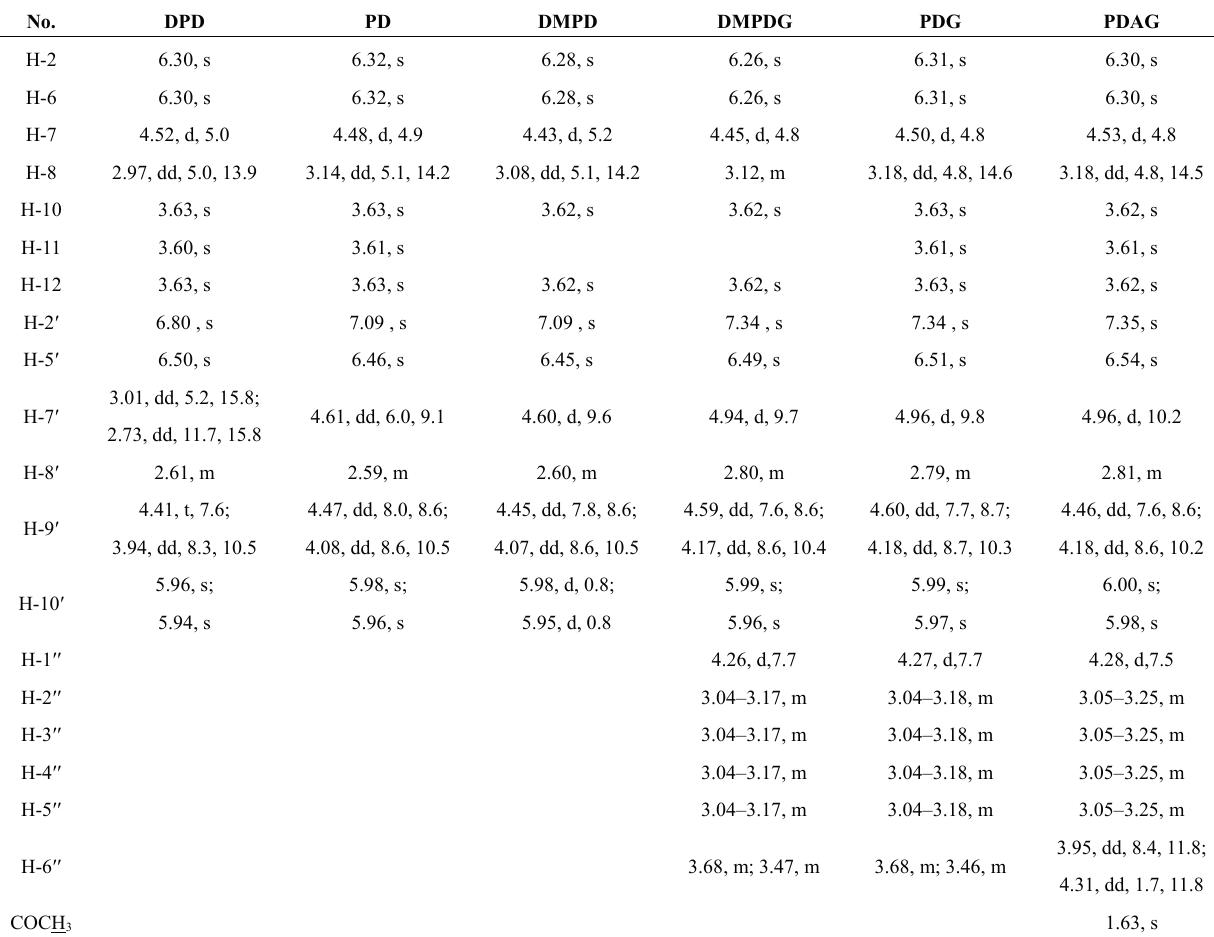
Table 4. 1 H-NMR data for six aryltetralin lactone lignans (500 MHz, DMSO- d 6 , δ H ( J in